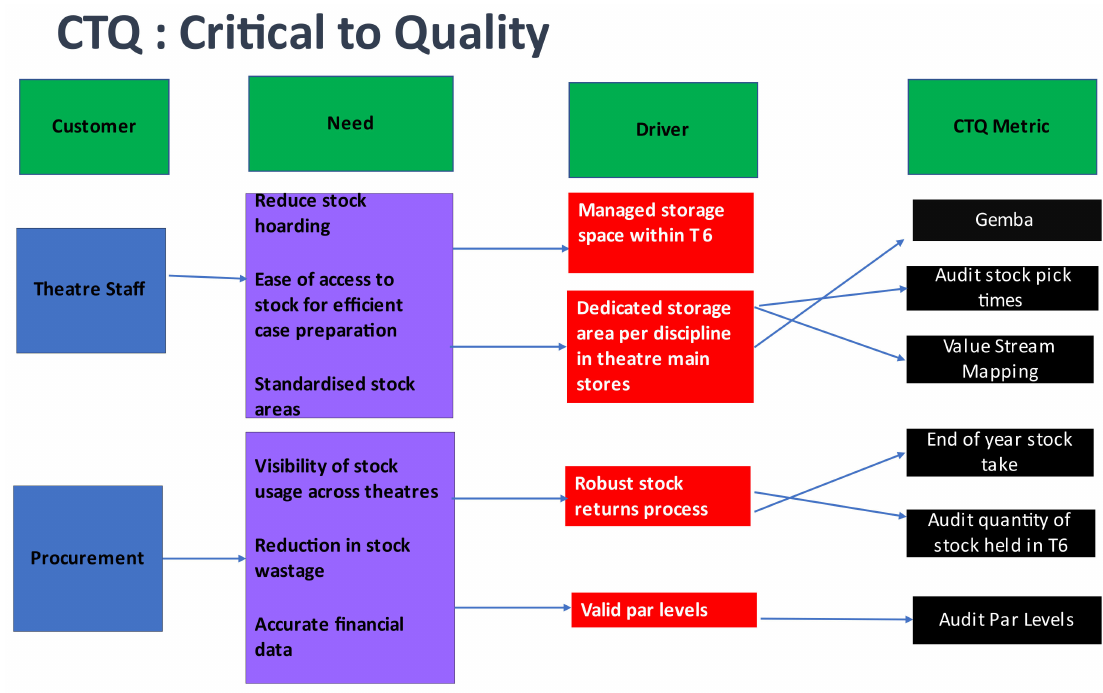
Figure 1. Critical to Quality Tree